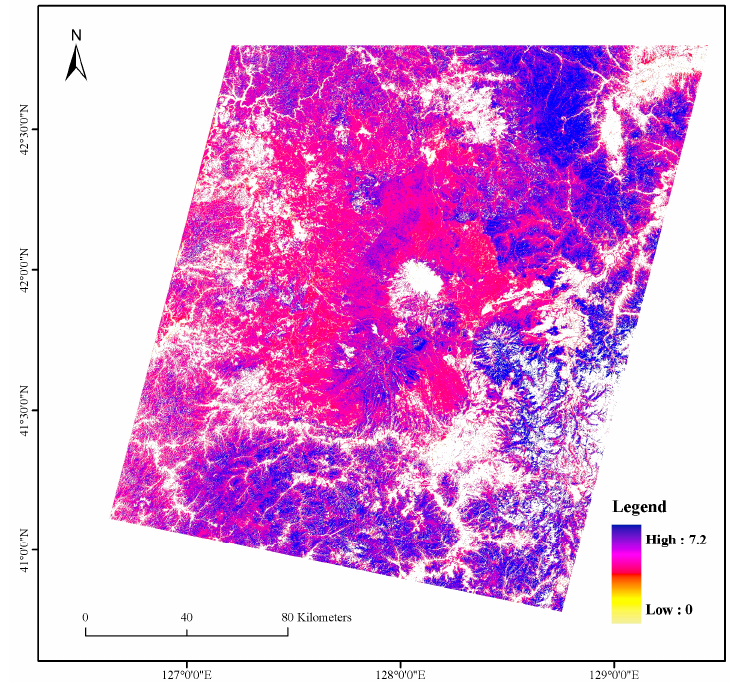
Figure 2. LAI Figure 2. LAI map.